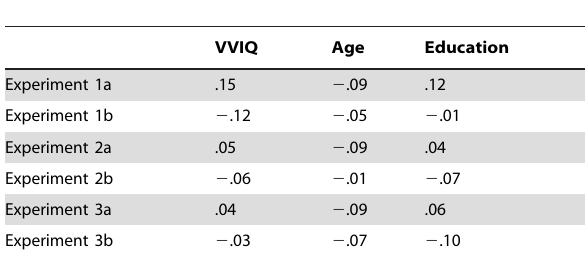
Table 2. Correlations Between Individual Effects Sizes and Scores on the VVIQ (Vividness of Visual Imagery Questionnaire), Age, and Educational